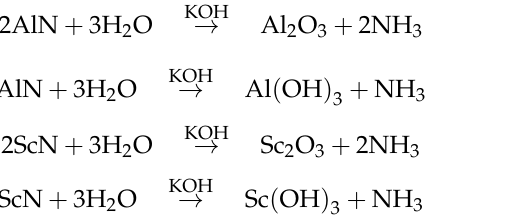
Figure 2. ( a ) Al 1 − x Sc x N and SiN x hard mask deposition; ( b ) photoresist patterning; ( c ) SiN x dry etch; ( d ) resist stripping and Al 1 − x Sc x N KOH wet etch. The opening area for the etching is 30 × 200 µm 2 .